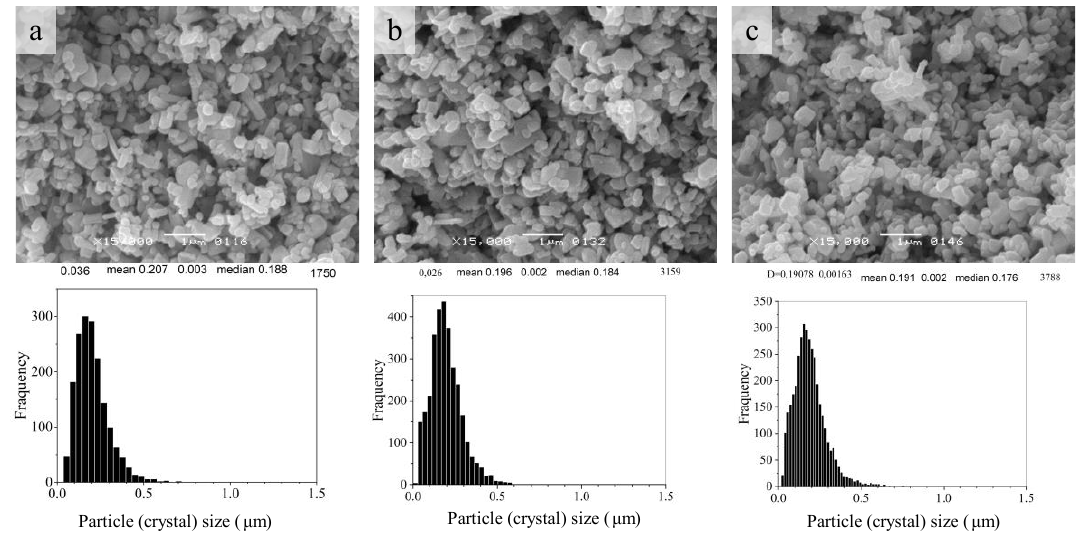
Figure 3. SEM image and crystal size distribution of ZnO powder after activation by the impregna-